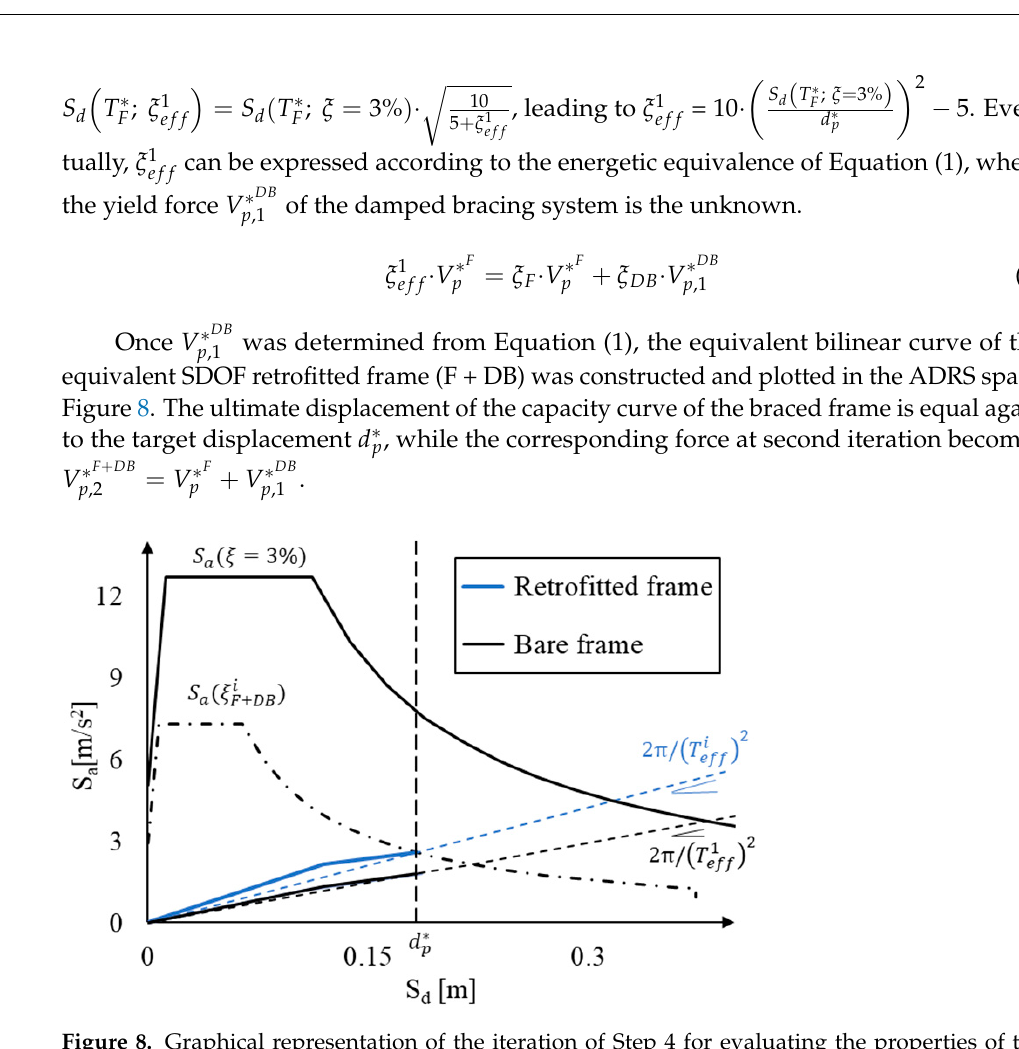
Figure 8. Graphical representation of the iteration of Step 4 for evaluating the properties of the equivalent SDOF damped equivalent SDOF damped brace.